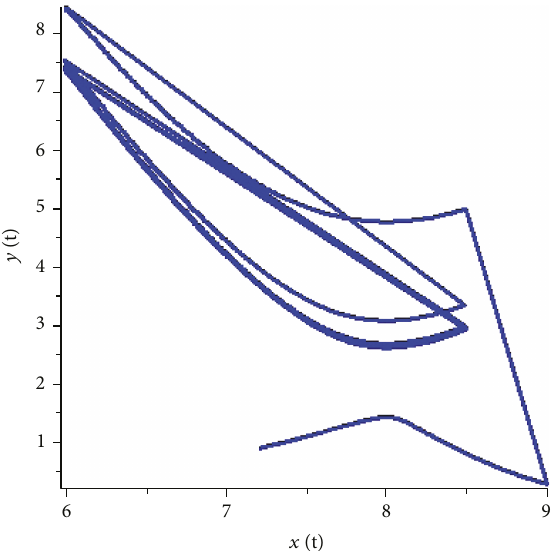
Figure 22: There exists an order-1 periodic solution in system (16) with q 1 = 1/18 , p = 0 6 , and τ = 4 7 .